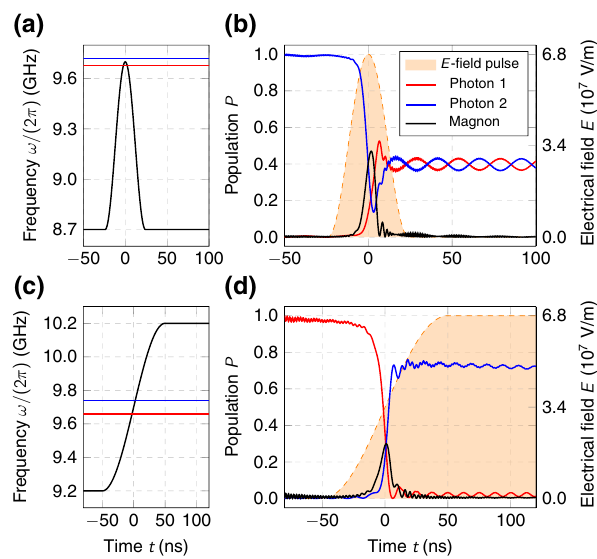
FIG. 5. All-electrical coherent magnon-photon quantum oper- ations in the ferromagnetic phase of Cu 2 OSeO 3 . (a),(b) Photon SPLIT operation with a full-period cosine E -field pulse. (a) Time dependence of the bare photon (red and blue) and magnon fre- quencies (black). (b) Time dependence of the modes’ population upon the electric field pulse. The quantum information of a max- imally populated photon (blue) gets split into two parts (blue and red). (c),(d) Photon SWAP operation with half-period cosine E - field pulse. (c) Time dependence of the bare photon (red and blue) and magnon frequencies (black). (d) Time dependence of the modes’ population upon the electric field pulse. The quantum information of a maximally populated (red) and empty photon (blue) gets swapped. For both operations, losses are associated with the magnon damping. For the parameters used, see the